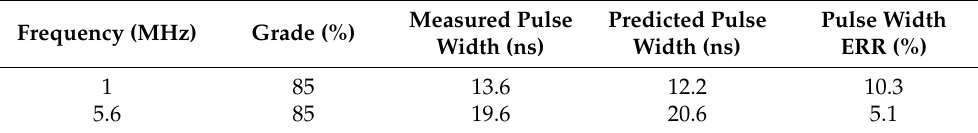
Table 3. The ERR of half width between measurement and prediction of 1 MHz and 5.6 MHz.